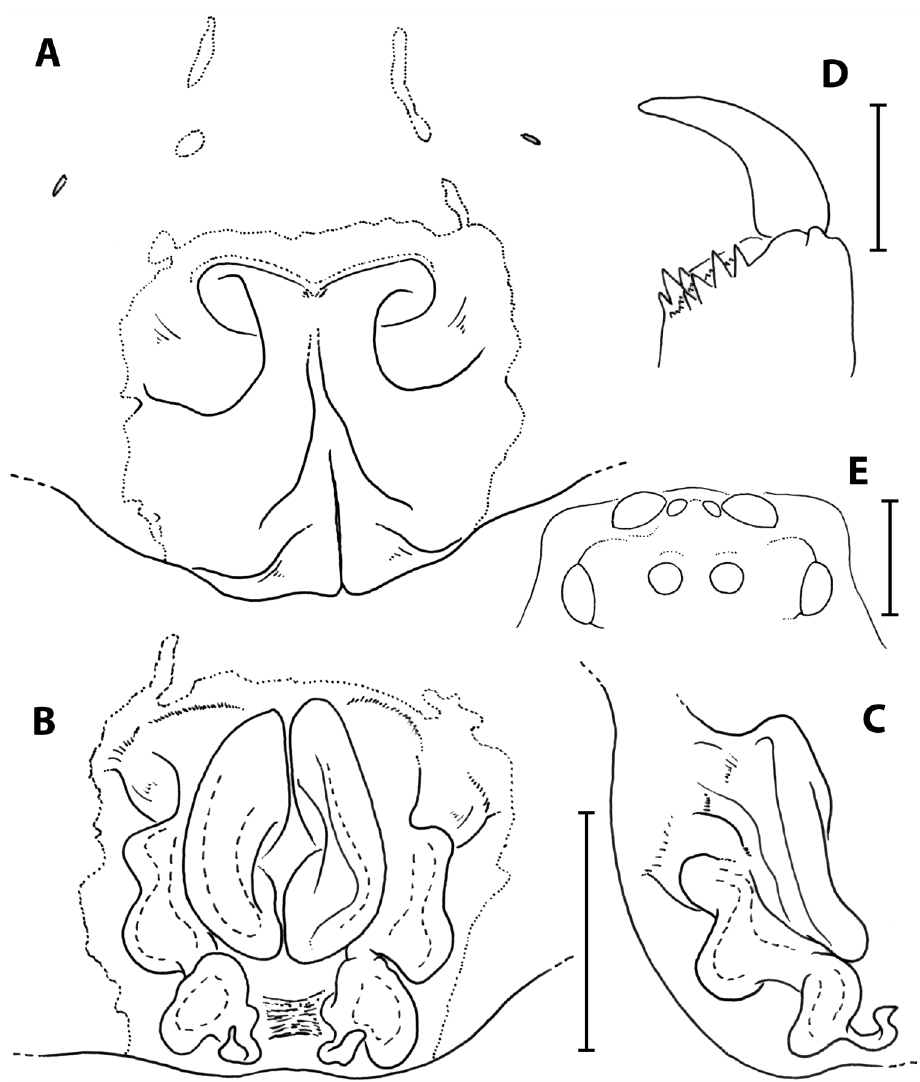
Figure 7. Spariolenus hormozii sp. n., female holotype, Hormozgan Province, Hamag Protected area, Iran (SMF). A epigynum, ventral B vulva, dorsal C right vulva, lateral D chelicerae, ventral E eye arrange- ment, dorsal. Scale bars: 1